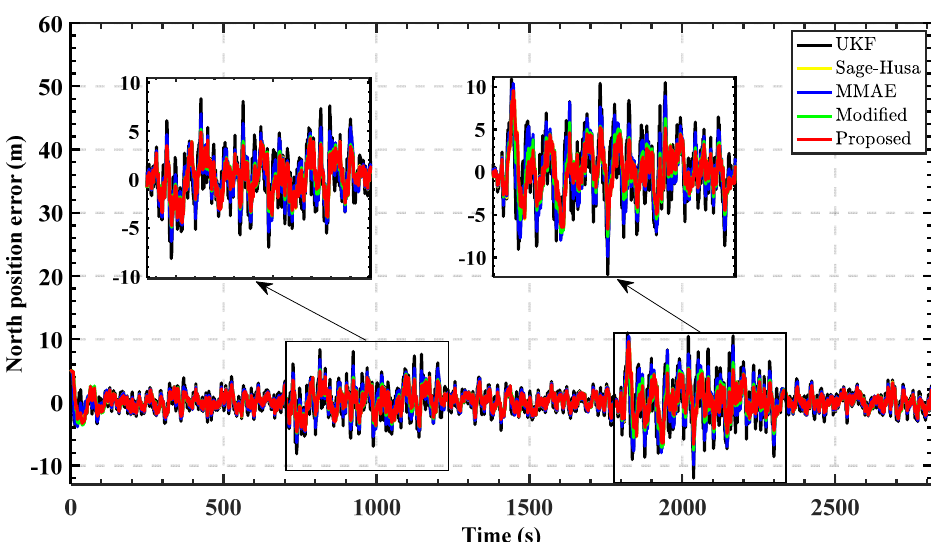
Sensors 2022 , 22 , x FOR PEER REVIEW Figure 5. East position errors comparison of different method. Figure 5. East position errors comparison of different method.